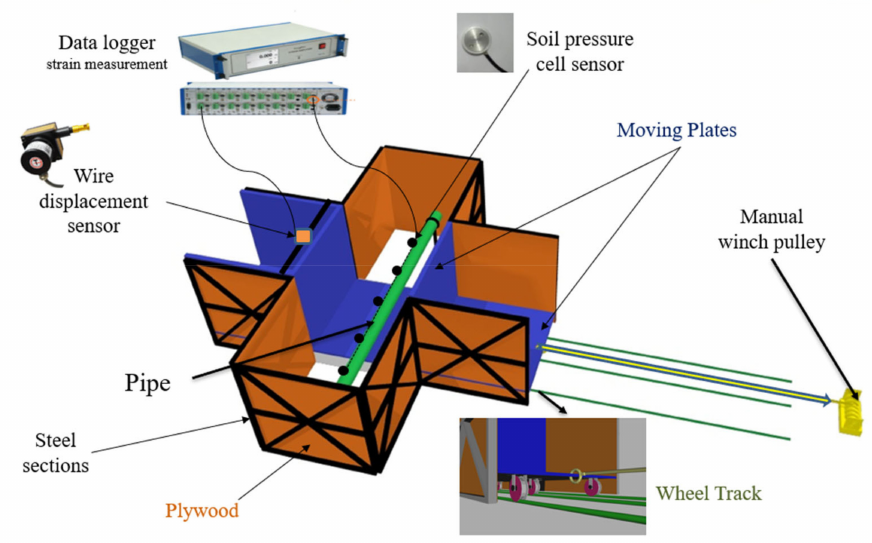
Figure 2. The large-scale model of soil–pipeline interaction. Table 1. The materials’ properties used in the research. Soil HDPE